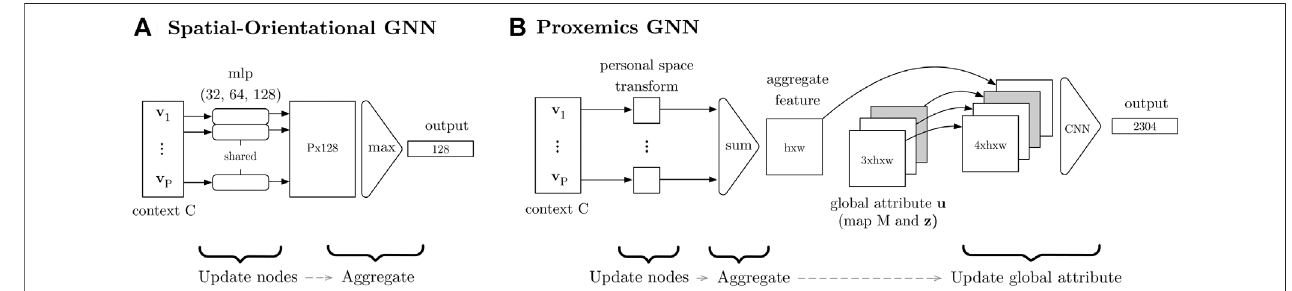
FIGURE 4 | Graph neural networks used in the generator. The “ mlp ” component in (A) is a multi-layer perceptron and “ CNN ” in (B) is a convolutional neural